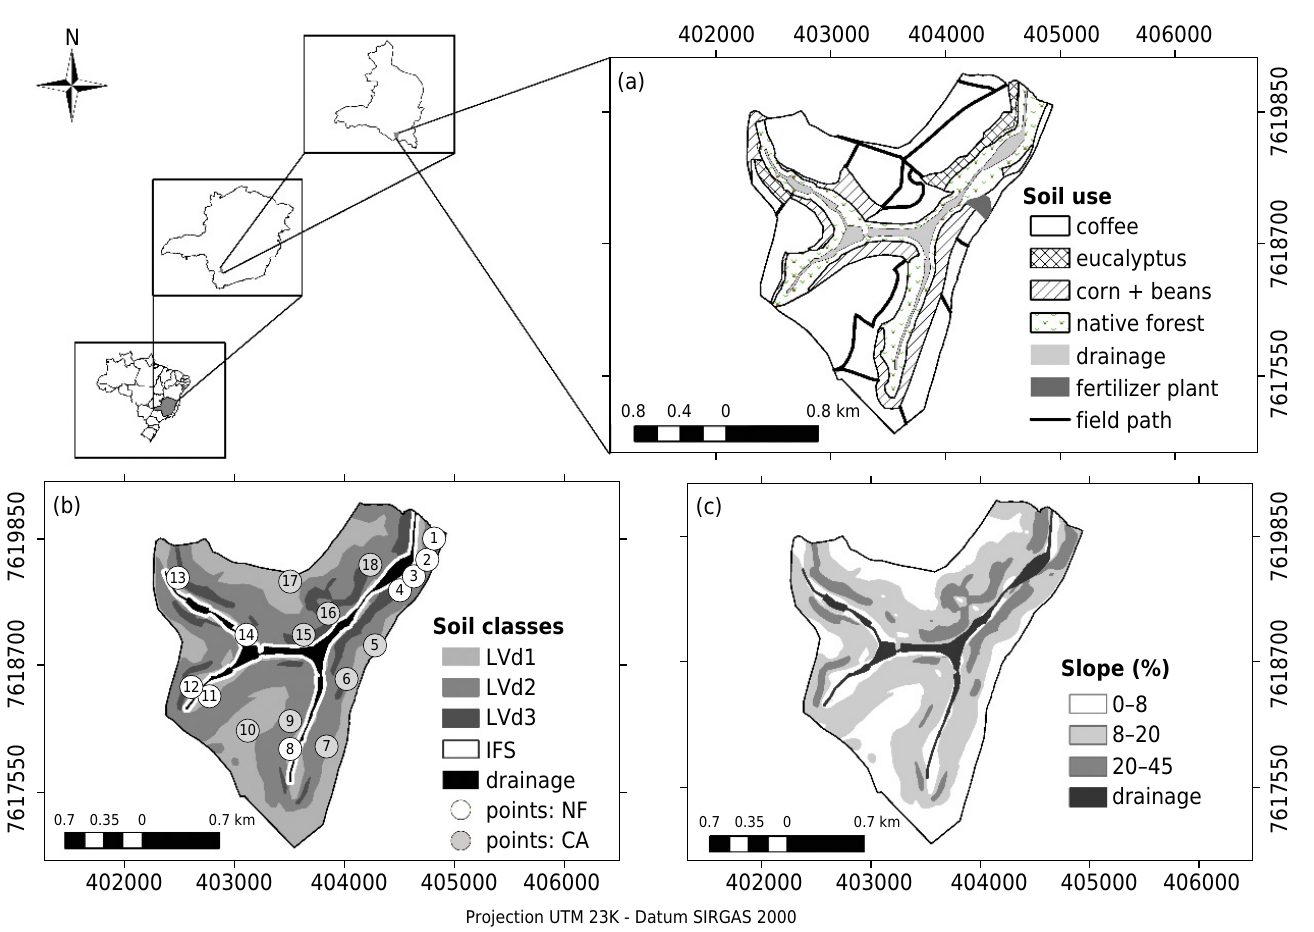
Figure 1. Map of the location of the Córrego da Laje Hydrographic Sub-basin, Alfenas, MG, and its current use (a); map of soils with soil collection sites in native forest (NF) and the coffee crop (CA), with the following soil classes: Oxisols ( Latossolos Vermelhos Distróficos ) in flat to slightly rolling (LVd1), rolling (LVd2), and strongly rolling (LVd3) relief; indiscriminate floodplain soils (IFS) (b); and slope map